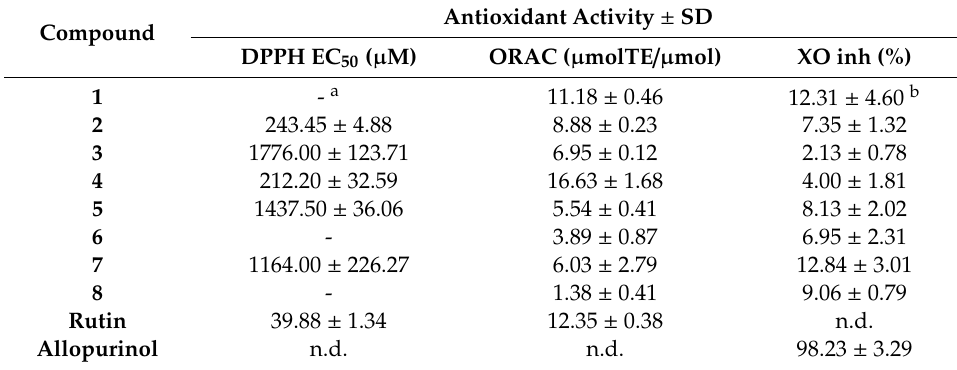
Table 2. Antioxidant activity of compounds 1 – 8 . TE: trolox equivalent; XO inh: xanthine